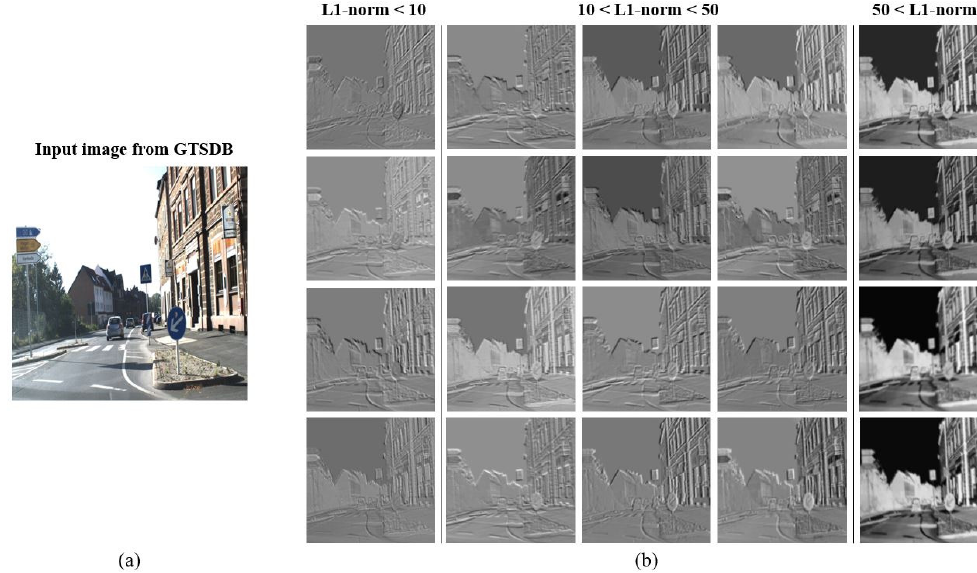
Figure 1. Examples of feature maps sorted by L1-norm values: ( a ) original images from GTSDB; ( b ) obtained feature maps from